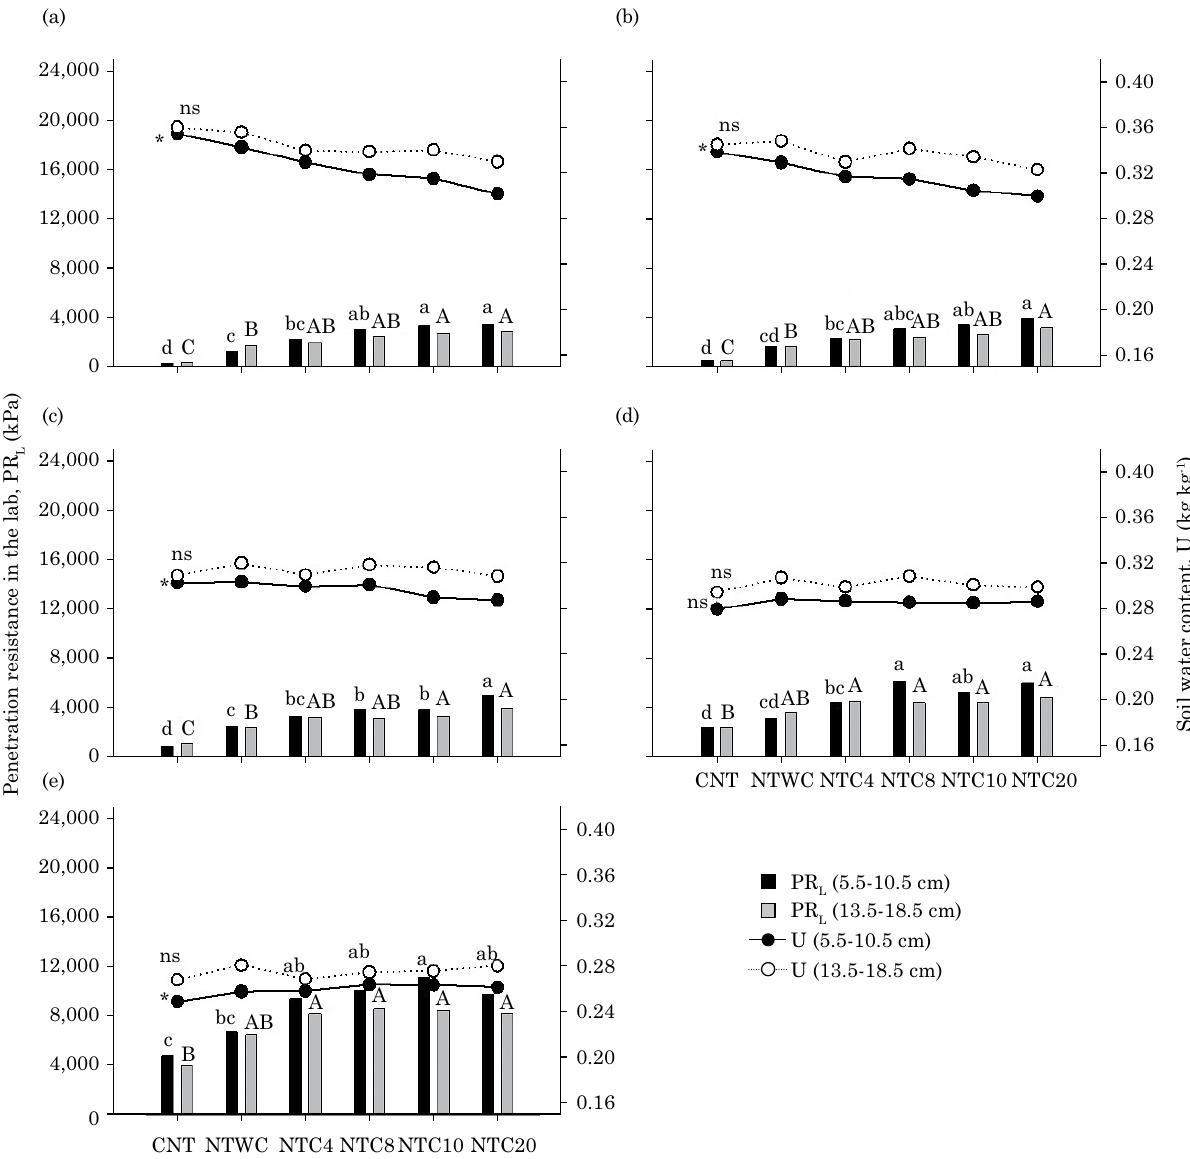
figure 4. Mechanical strength of soil penetration in the laboratory (pr l ) and gravimetric soil water content, as related to degrees of compaction [no-tillage (NT) chiseled (CNT); NT without additional compaction (NTWC); NT with additional compaction of a combine passing 4 (NTC4), 8 (NTC8), 10 (NTC10), and 20 (NTC20) times] over a Rhodic Eutrudox, in the 5.5-10.5 and 13.5-18.5 cm layers, the matric potential of -6 (a), 10 (b), -33 (C), -100 (D), -500 KPa (e). Means followed by the same uppercase letter (5.5-10.5 cm layer) or lowercase letter (13.5-18.5 cm layer) do not differ by the Tukey test (p<0.05); ns: not significant by the F test